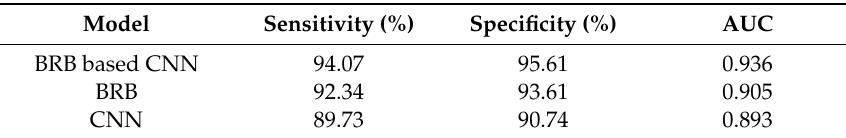
Table 6. Comparison of Reliability among three